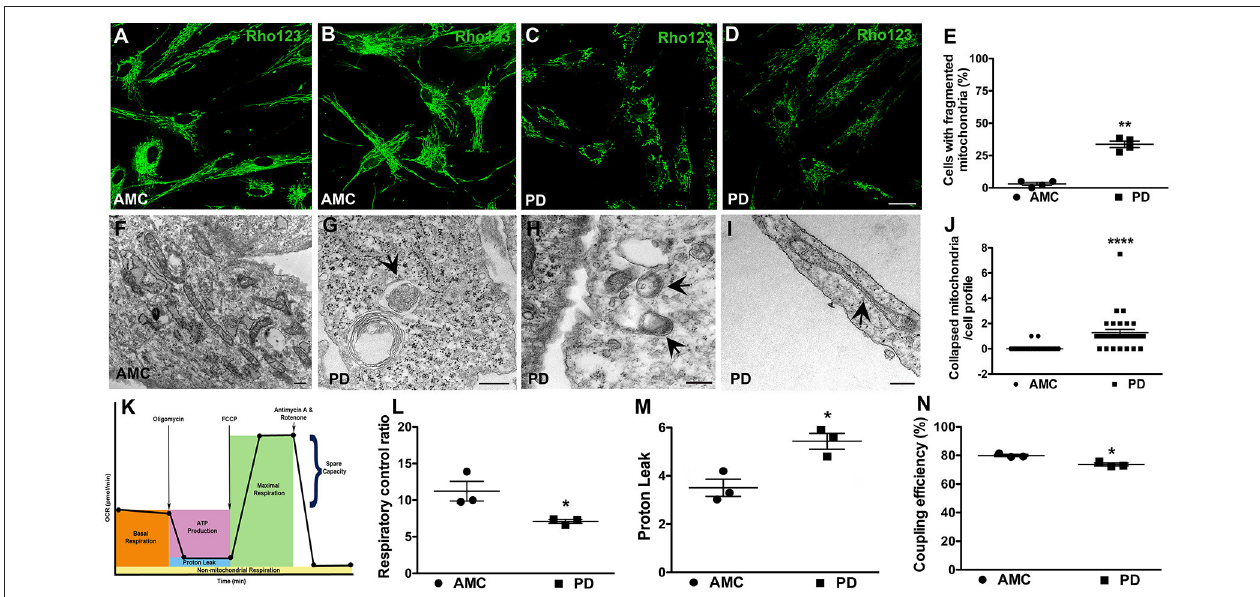
FIGURE 4 | Mitochondrial dysfunction in PD fibroblasts. Rhodamine 123 stained fibroblasts showing bright and typical mitochondrial network morphology in AMC cells (A,B) but low intensity fragmented mitochondria in PD fibroblasts (C,D) . (B,D) are maximum intensity projection images from confocal z-stacks. Rhodamine 123 quantification is in (E) . Electron micrograph displaying normal mitochondrial morphology in AMC cells is depicted in (F) . PD cultures on the other hand showed abnormal features such as mitophagy (G) , mitochondria lacking cristae (H) , and collapsed mitochondria (I) . Quantification of collapsed mitochondria is in (J) . Schematic depicting the steps of the mitostress test is in (K) . RCR is significantly lower on average (L) , and PL is significantly higher, in PD cells (M) . Relatively lower CE is seen in PD lines on average (N) . Scale Bars: (A–D) = 40 µ m; (F–I) = 250nm. * p < 0.05, ** p < 0.01, **** p < 0.0001; Mean ± SEM, Unpaired t -tests with Welch’s correction (E) and two-way ANOVA with Tukey’s post-test (L–N) ; Median ± interquartile range, Mann Whitney U -test (J) ; n = 3–4 independent PD and AMC